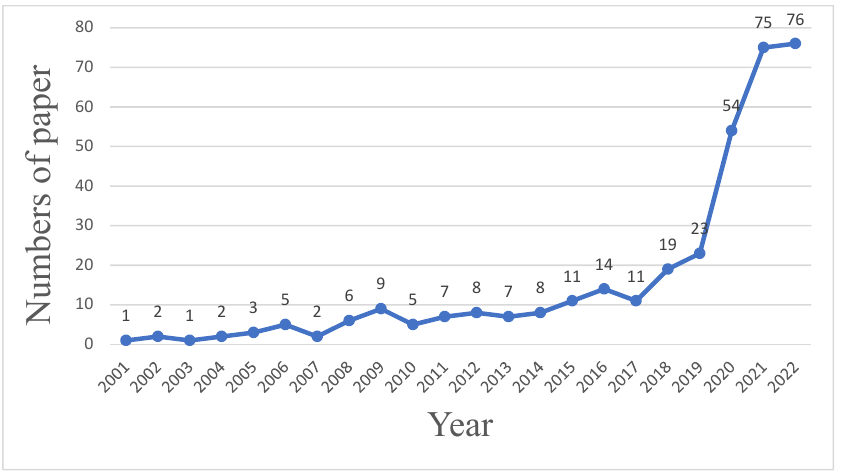
Figure 1. Number of articles published per year.